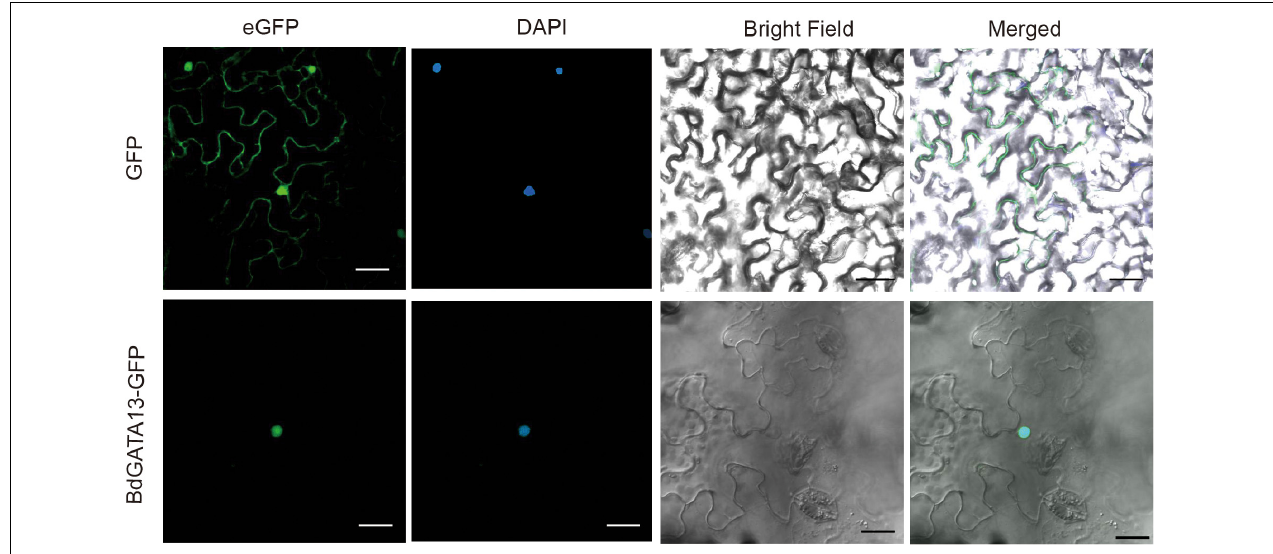
FIGURE 6 | Subcellular localization of BdGATA13 protein. 35S: BdGATA13 -GFP was transferred into tobacco leaves, and fluorescence signals of GFP were detected in tobacco leaf epidermal cells. Left panel, GFP image; middle panel, bright field; and right panel, merge of GFP and bright field. Bar, 10 µ